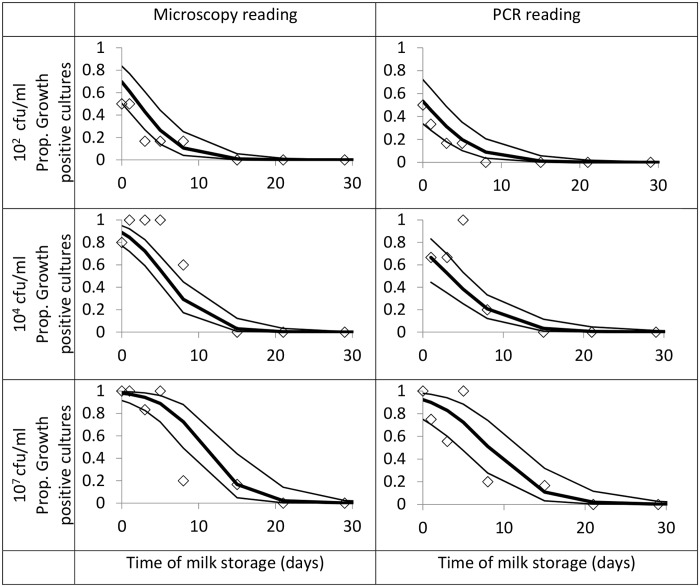
Results of Ziehl-Neelsen staining and PCR amplification of M. bovis isolated from milk spiked with different doses and stored at 20°C.The left column presents the results using outcome of ZN staining as response variable, whereas a serial combination of microscopy and PCR was used in the right column. Graphs include raw data (◊), estimated means (▬) and the 95% confidence intervals (─). Graphs were truncated on the right because no AFB positive cultures were observed after day 30.